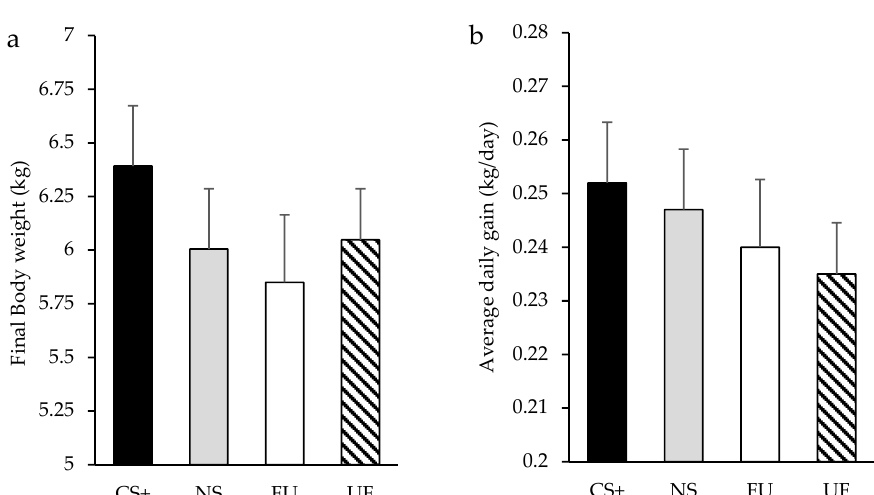
Figure 3. Daily intake of creep feed diet by piglets (days 14 to 18) who were offered (from days 10 to 20 of the suckling period) either the same flavor in their diet than their mothers in the late-gestation (90-114d; CS+), a different flavor (NS), an unflavored creep feed diet (FU), or a flavored creep diet, but born from a mother that was fed an unflavored maternal diet (UF). Results expressed as Least Square means ± SEM.